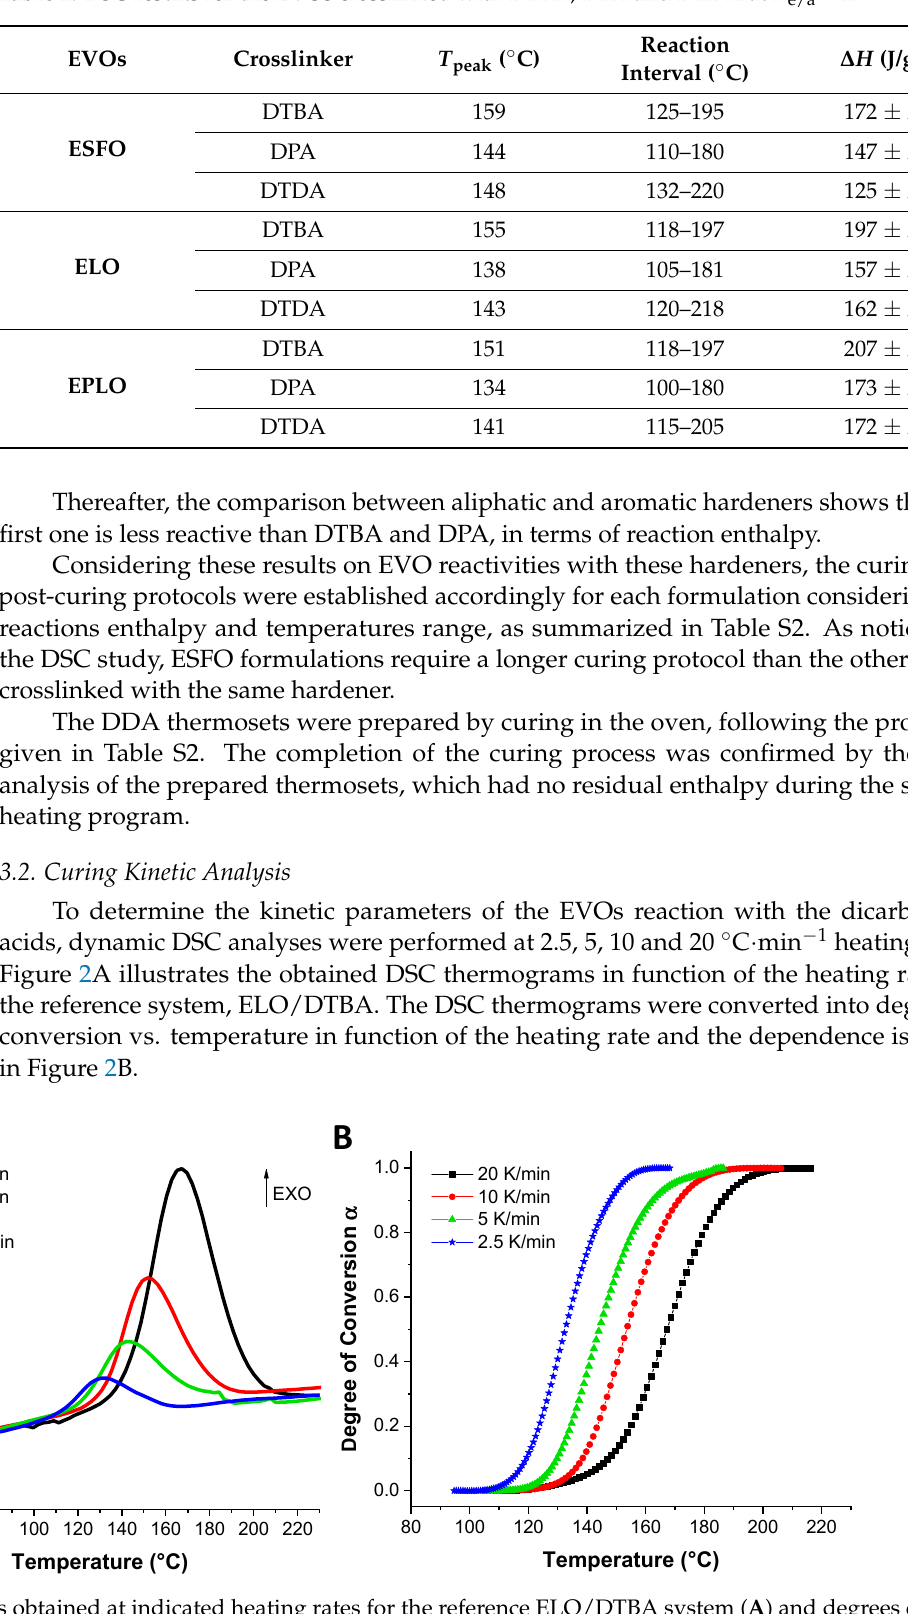
Table 1. DSC results for the EVOs crosslinked with DTBA, DPA and DTDA at R e/a = 1.